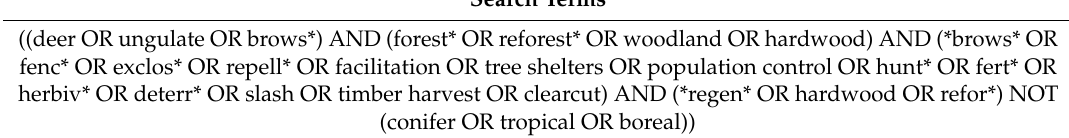
Table 1. Search terms used in the systematic search of the electronic database Web of Science. Asterisks (*) are wildcard operators. Search Terms